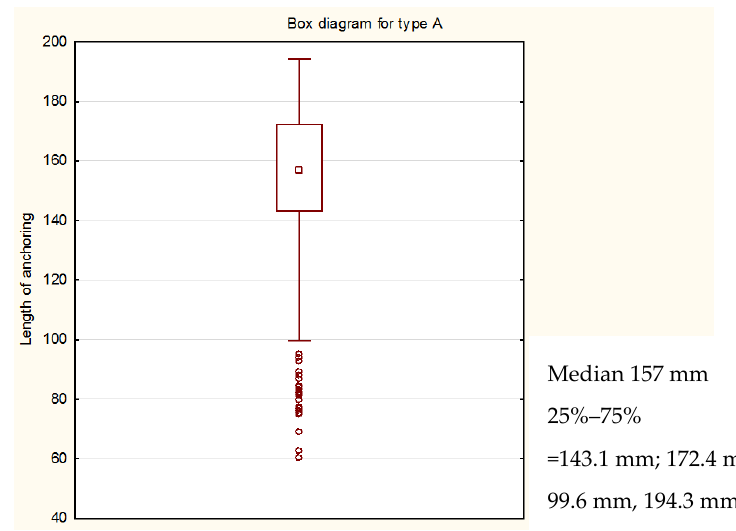
Figure 2. Box diagram for type A anchoring.